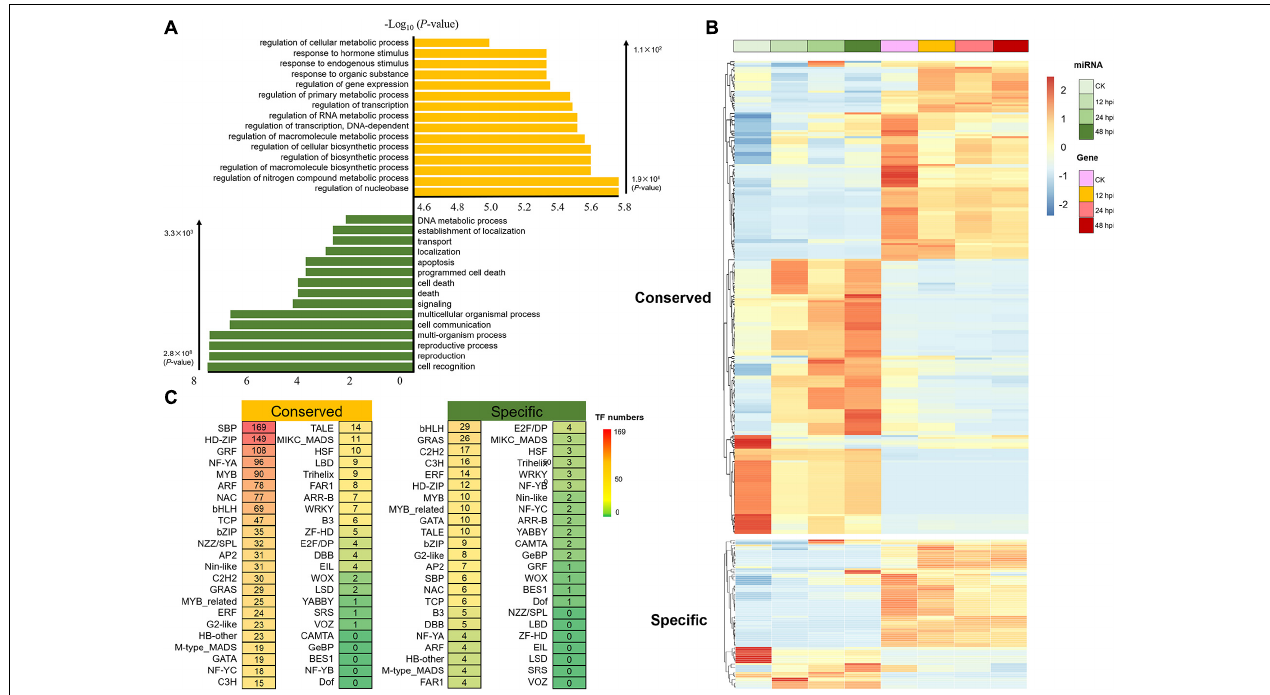
FIGURE 3 | Analysis of the target of conserved and Populus -specific miRNAs. (A) Significantly enriched Gene Ontology biological processes for target genes of conserved and Populus -specific miRNAs, respectively (Top 15; P < 1 × 10 - 2 ). (B) Expression of the miRNA/target genes with negatively correlated expression patterns ( r < –9 × 10 - 1 , P < 5 × 10 - 2 ; Pearson correlation). (C) The number of transcription factor (TF) targets of conserved and Populus -specific miRNAs,